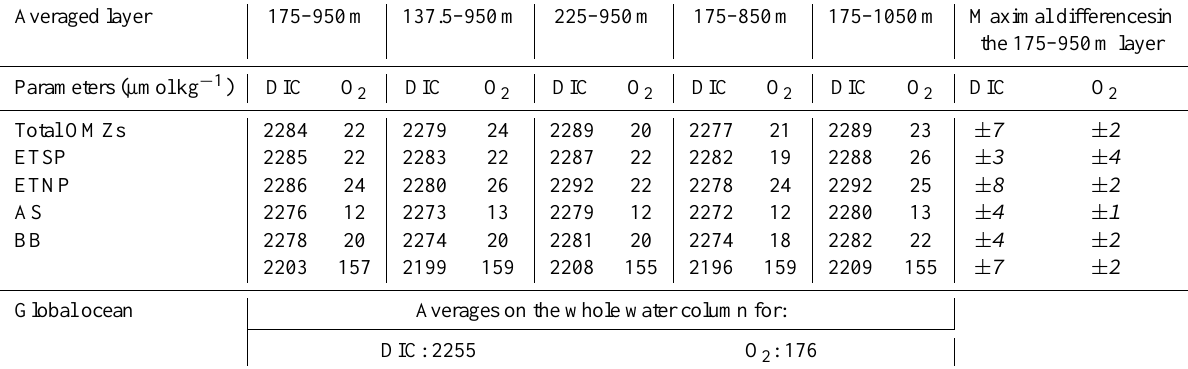
Table 1. Averaged DIC and O 2 concentrations in a mean layer intercepting the core of all main OMZs (175–950m), and sensitivity tests (in italics; commented in §3.2) on upper (for 137.5 and 225m) and lower limits (for 850 and 1050m) from GLODAP and WOA2005 databases. Averages are given for tropical OMZs together (ETSP + ETNP + AS + BB) and separately, and for the global ocean. ETNP: Eastern Tropical North Pacific; ETSP: Eastern Tropical South Pacific; AS: Arabian Sea; BB: Bay of Bengal. Averaged layer